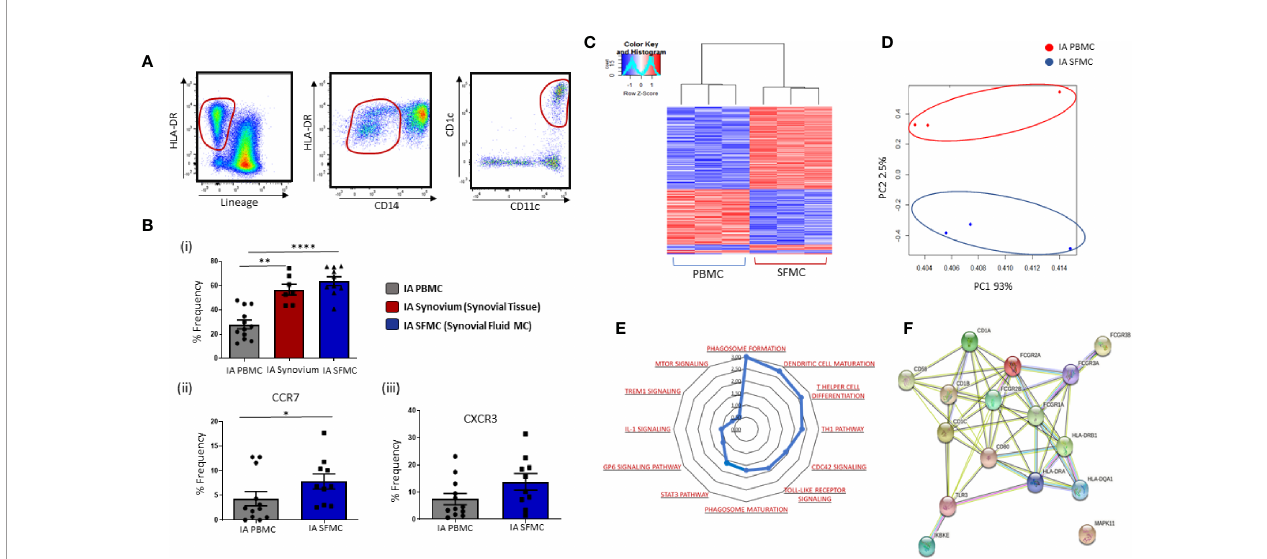
FIGURE 3 | Distinct Transcriptomic Variation in Synovial CD1c+ DCs in IA. (A) Gating strategy to identify CD1c + DCs in IA SFMC. Following the elimination of debris, doublets, and dead cells, cells were gated as Lineage – HLADR + CD14 − CD11c + CD1c + . (Bi) Comparative percentage frequency of CD1c + DCs in IA PBMC (n=12), IA synovial tissue (n = 7), and IA SFMC (n = 7). (Bii, iii) The percentage frequency of CCR7 + CD1c + DCs and CXCR3 + CD1c + DCs in IA PBMC (n = 12) and IA SFMC (n = 10). CD1c + DC frequency is represented as a percentage of cells in the mDC gate. (C) Hierarchical clustering analysis following RNAseq on DEG from CD1c + DCs IA PBMC (n = 3) and IA SFMC (n = 3). (D) PCA of total datasets from CD1c + DCs from IA PBMC and IA SFMC. (E) Radar plot representing enriched pathways in CD1c + DCs from IA SFMC CD1c+DCs compared to HC using IPA. (F) STRING pathway analysis of speci fi c DC maturation pathway gene